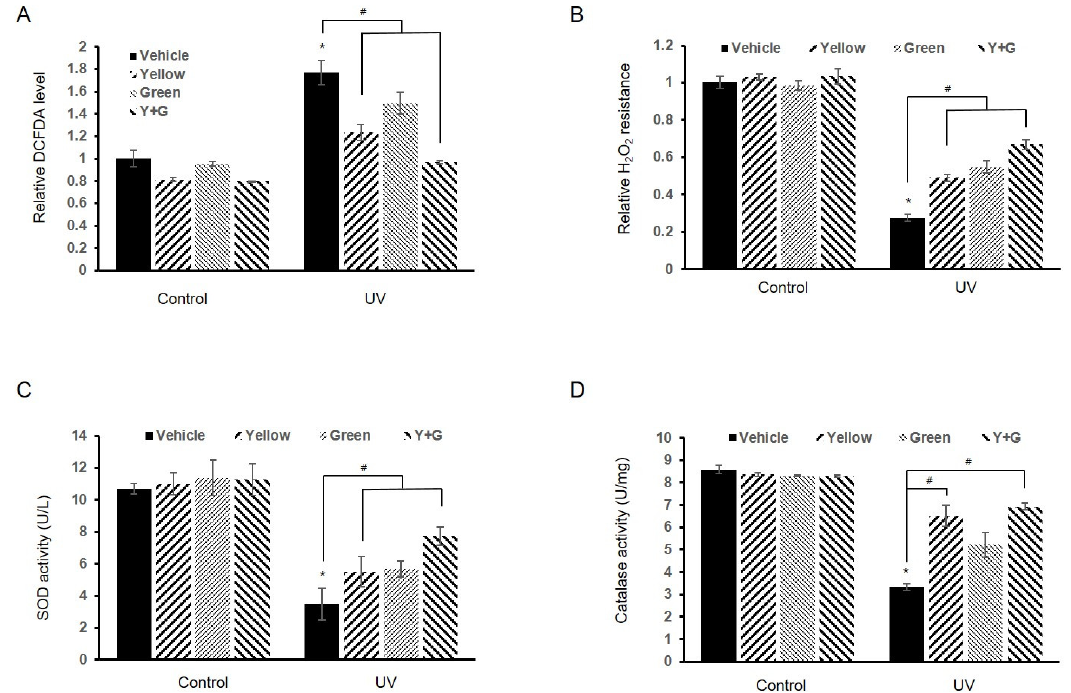
Figure 6. IPL reduces cellular oxidative stress levels and results in retention of antioxidative enzyme activity under UVB irradiation conditions. ( A ) Cellular reactive oxygen species (ROS) levels in the control group and the UVB-treated group were measured using a 2’,7’-dichlorofluorescein diacetate (DCFDA) assay. ( B ) Resistance to oxidative stress caused by hydrogen peroxide stimulation was investigated under IPL treatment conditions. ( C ) Superoxide dismutase (SOD) activity was examined in units per liter, and ( D ) catalase activity was evaluated in units per mg in NHEK lysates using an antioxidative enzyme assay. # p < 0.001 compared to the UVB-treated vehicle group; * p < 0.001 compared to the control vehicle group.